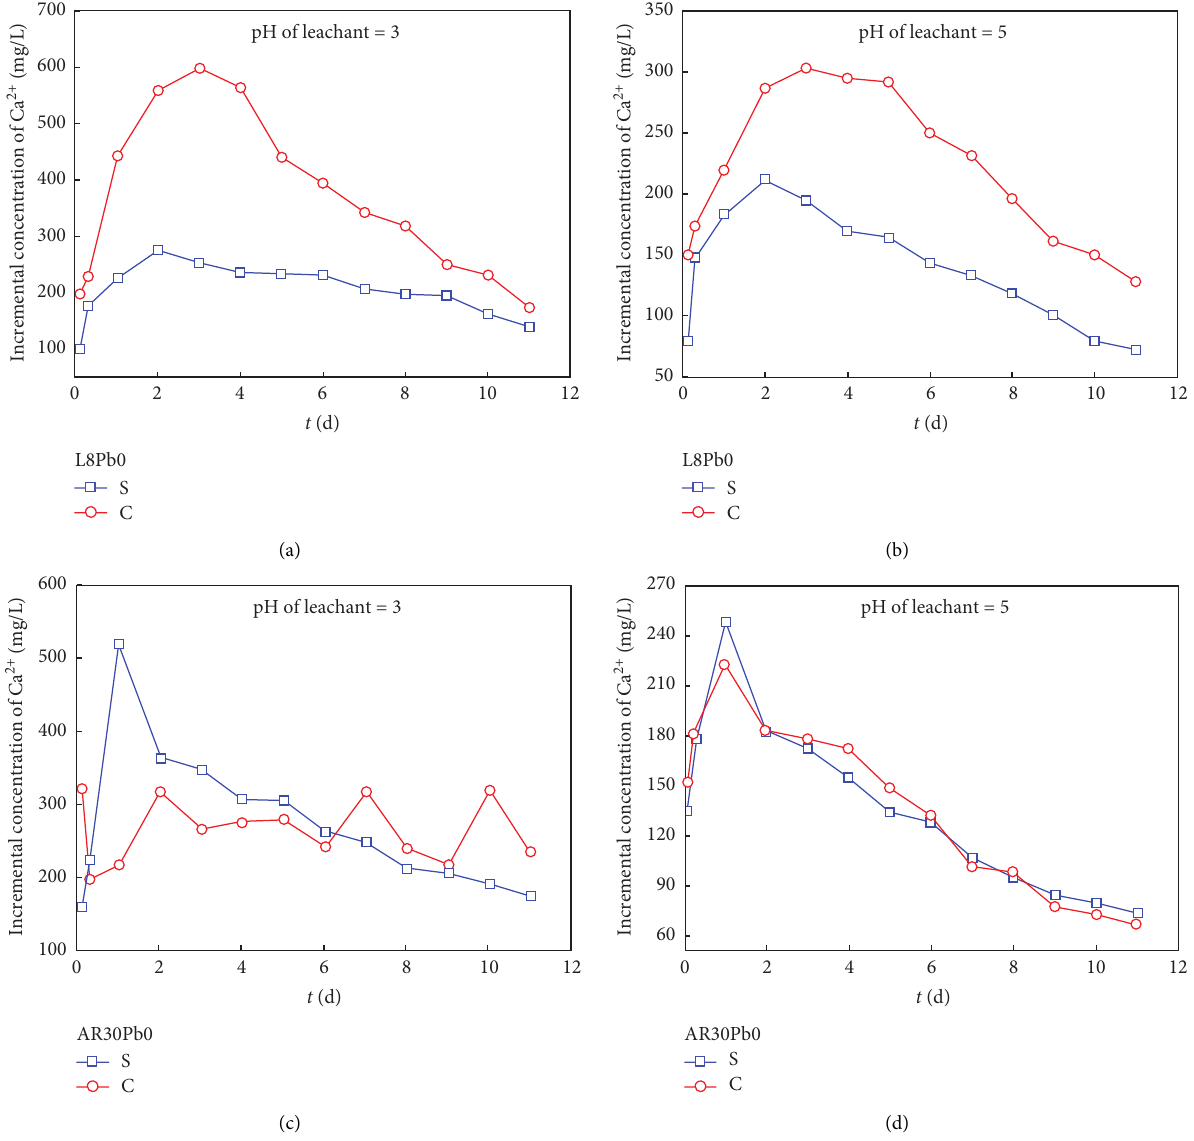
Figure 6: The evolution of incremental concentration of Ca 2+ in leachate with time: (a) L8Pb0, leachant pH of 3; (b) L8Pb0, leachant pH of 5; (c) AR30Pb0, leachant pH of 3; (d) AR30Pb0, leachant pH of